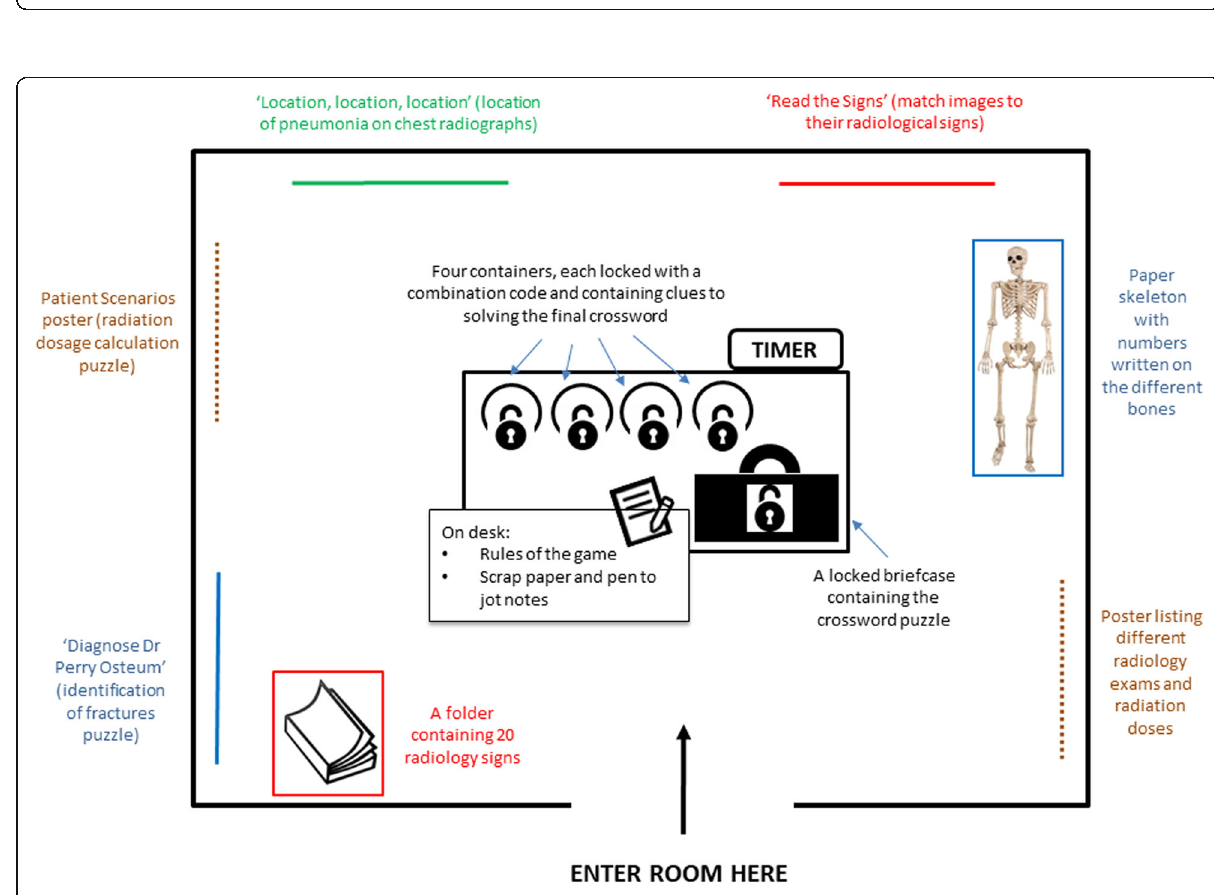
Fig. 7 The layout of the escape room. The puzzles listed in Figs. 1, 2, 3 and 4 are colour coded in this image. Those with more than one component are intentionally placed on opposite sides of the room to force students to interact with each other and communicate findings. The escape room rules read to students prior to the activity had already informed them that removing posters from the wall or use of mobile phones was not